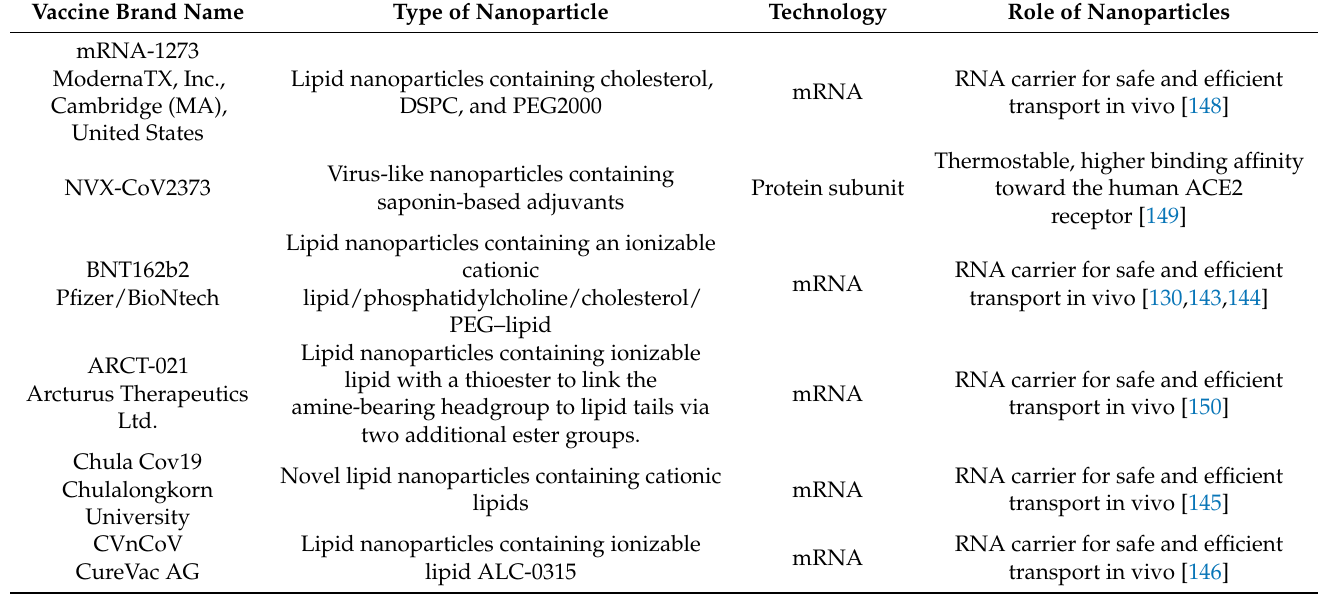
Table 1. Main nanoparticles for COVID-19